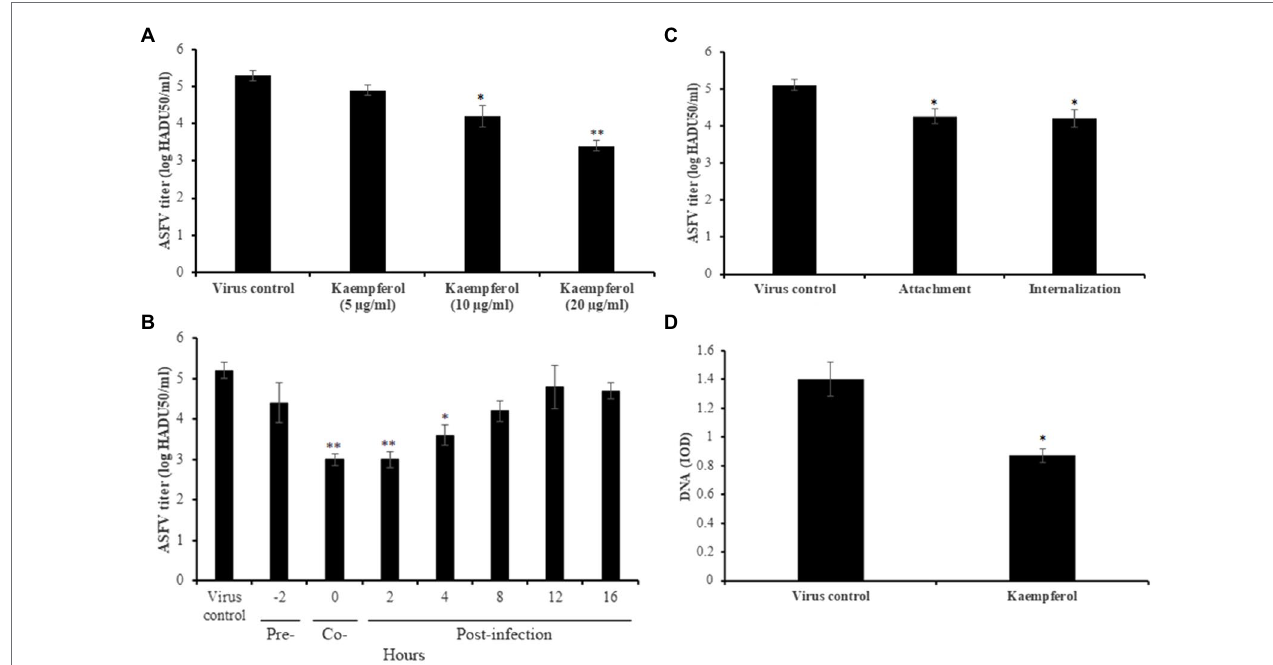
FIGURE 5 | Antiviral activity of kaempferol against ASFV Arm/07 isolate in porcine macrophages. (A) ASFV titer in macrophages treated with kaempferol at increasing concentrations from 5 μ g/ml (17.5 μ m) to 20 μ g/ml (70 μ m). (B) Effect of kaempferol on different stages of ASFV infection in macrophages. (C) Effect of kaempferol on ASFV entry into macrophages. (D) DNA content of ASFV factories in macrophages treated with 20 μ g/ml kaempferol. Results represent the mean (± SD) of three independent experiments ( n = 3). Significant differences compared to control are denoted by * p < 0.05 and ** p <